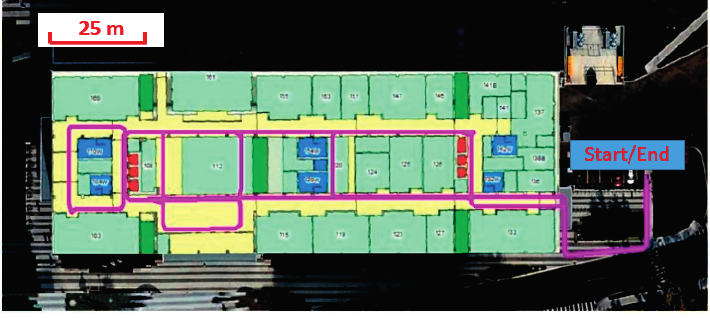
Figure 7. Test trajectory at EEEL (with abundant WiFi and magnetic